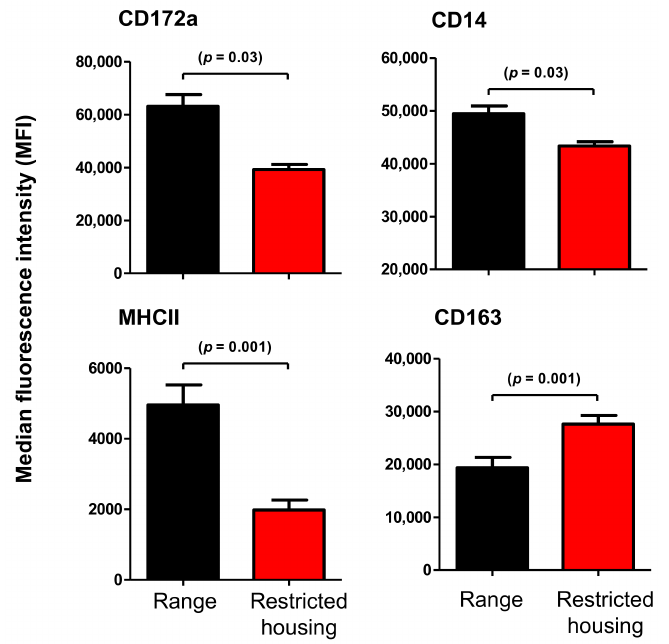
Figure 5. The effect of restricted housing on the expression densities of the main myeloid markers on camel monocytes. Leukocytes were labeled with monoclonal antibodies against CD172a, CD14, MHCII, and CD163, and labeled cells were analyzed by flow cytometry. The abundance of each cell marker was evaluated by median fluorescence intensity (MFI), and the results were presented as mean ± SEM.